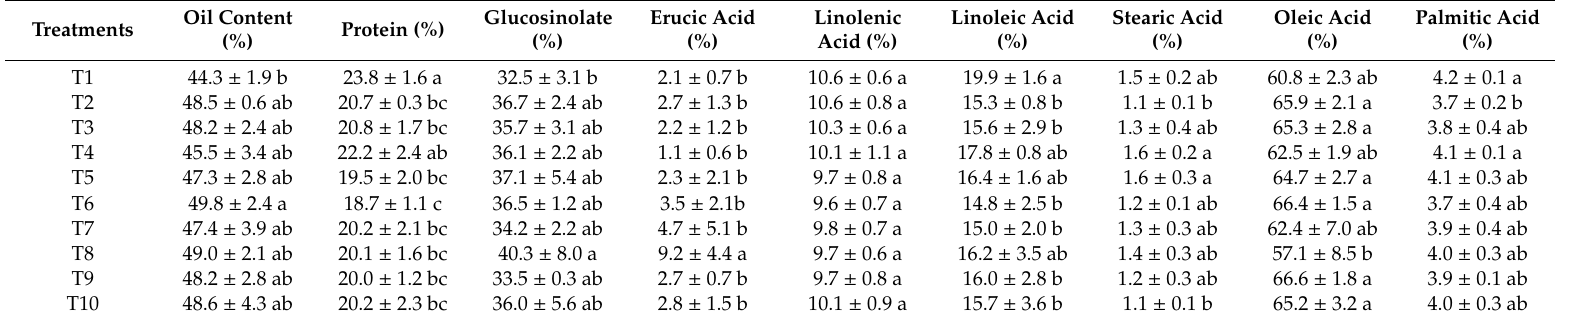
Table 4. The oil content and seed quality of Brassica napus under di ff erent